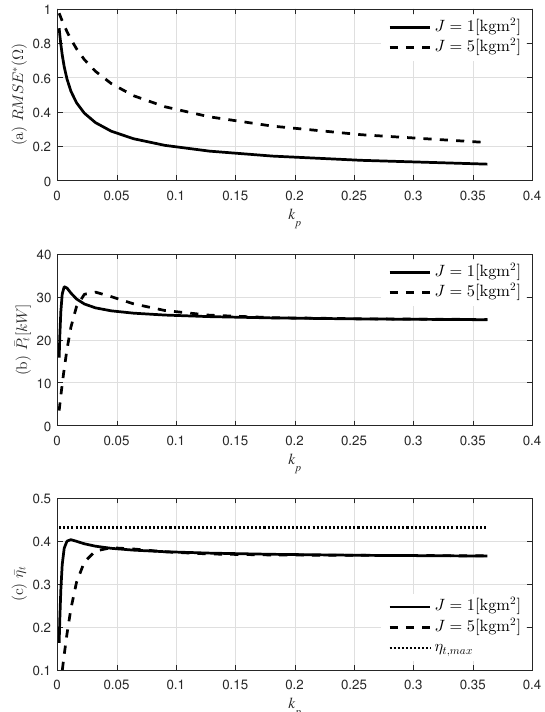
Figure 11. Results of the CAV controller with various k p under an equivalent irregular wave condition when Ω d = 550 rad/s: ( a ) relative root mean squared error of Ω ; ( b ) average power extraction from the turbine; ( c ) average turbine efficiency and its maximum